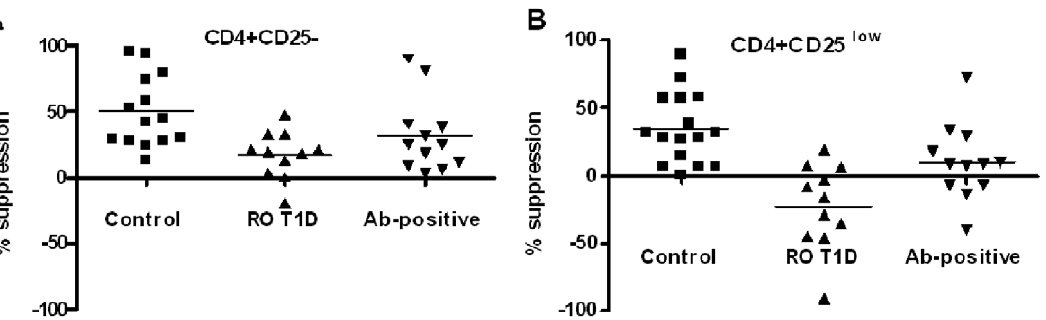
Figure 6. RO-T1D and aAb + ve unaffected subjects show dramatic decrease in suppression of CD4 + CD25 low -Tcell proliferation by Tregs. There was statistically significant difference in suppressive potential of CD4 + CD25- T cells between control, RO T1D and aAb + ve subjects (Kruskal-Wallis test, p=0.014, Figure 6A). However, the difference was even more pronounced with CD4 + CD25 low as responder T cells (Kruskal-Wallis test, p=0.0007, Figure 6B). Both RO T1D and autoantibody-positive subjects showed significant decrease in suppression of CD4 + CD25 low T cells (paired t-test, p=0.0025 and p=0.008) compared with their respective CD4 + CD25- T cells. In addition, there was significant difference in suppression of the two responder T cells in healthy control subjects